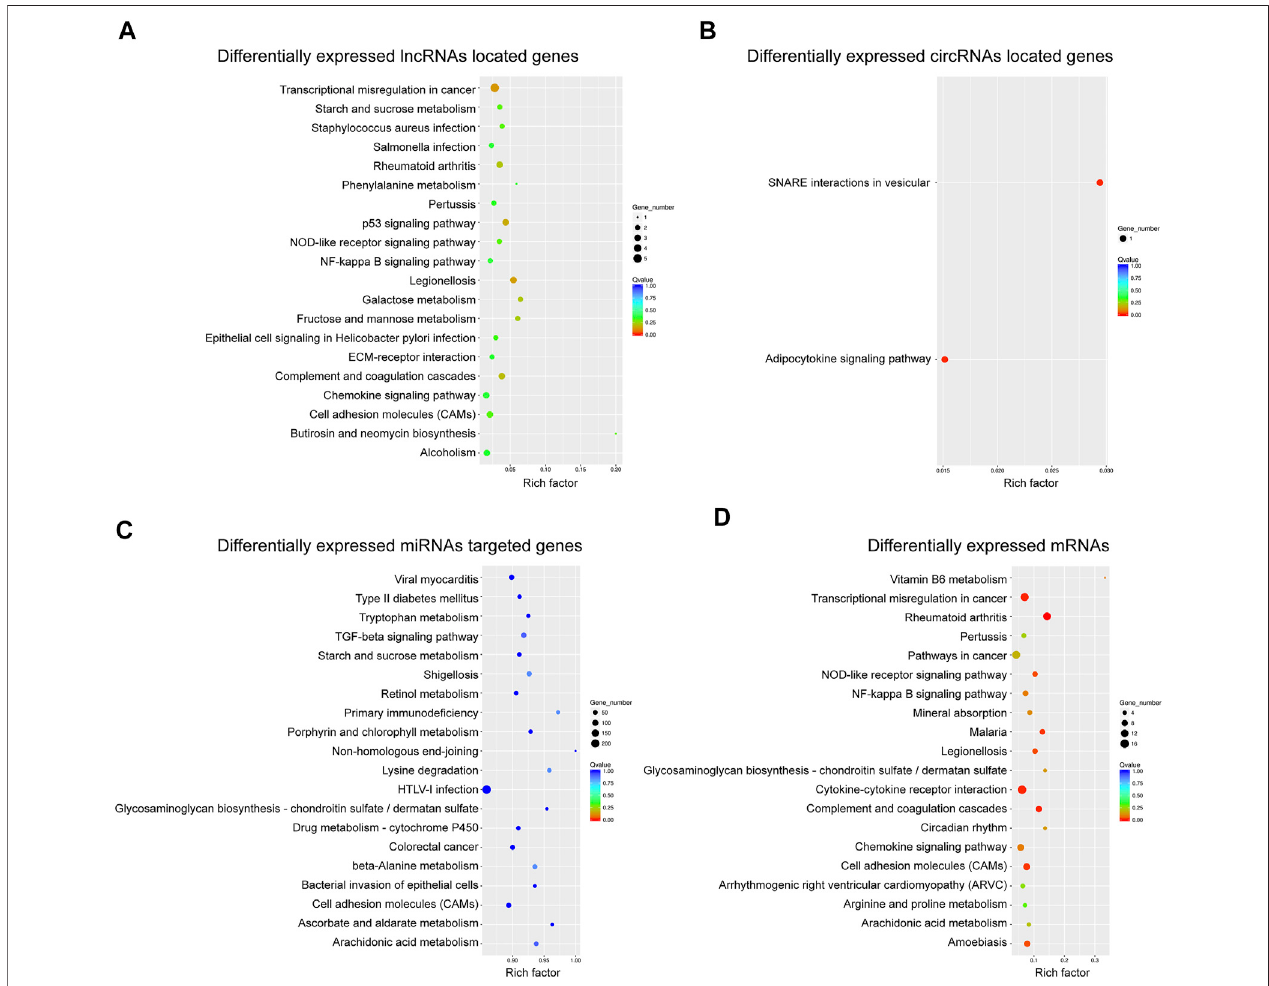
FIGURE4| KEGGpathwayanalysisofmRNAsandncRNAs.Top20KEGGpathwaysregarding (A) DEmRNAs; (B) DElncRNAs-locatedgenes; (C) DElncRNAs- targeted genes; (D) DE circRNAs-located genes; and (E) DE miRNAs-targeted genes.